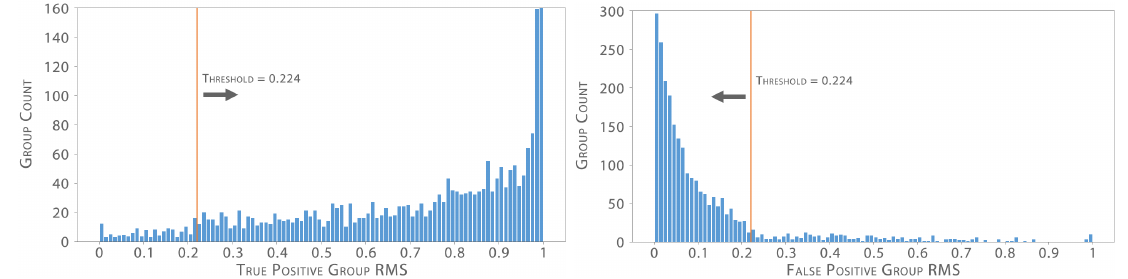
Figure 9. Response of CNN outputs for true positive (TP) and false positive (FP)